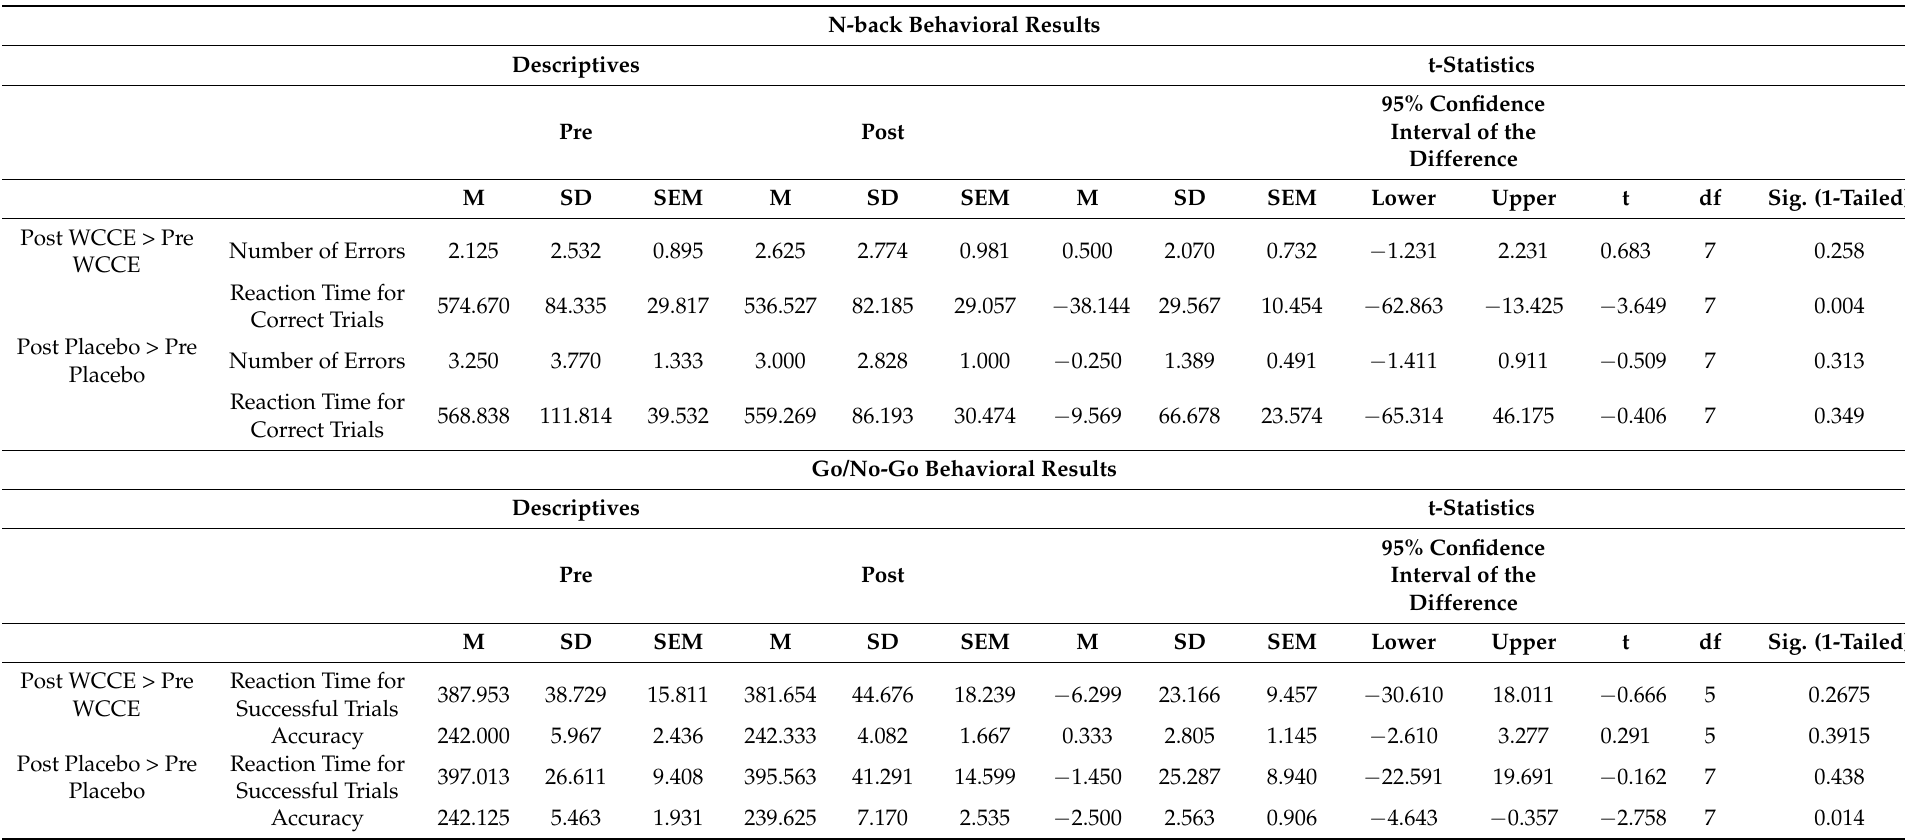
Table 3. Descriptive statistics of the behavioral tasks (i.e., n-back and go/no-go) performed in the scanner. Notably, for reaction time, we found significant reductions during the n-back task post-consumption for WCCE but not for the placebo. For accuracy, we found that accuracy during the go/no-go task declined post-consumption of the placebo but not post-consumption of